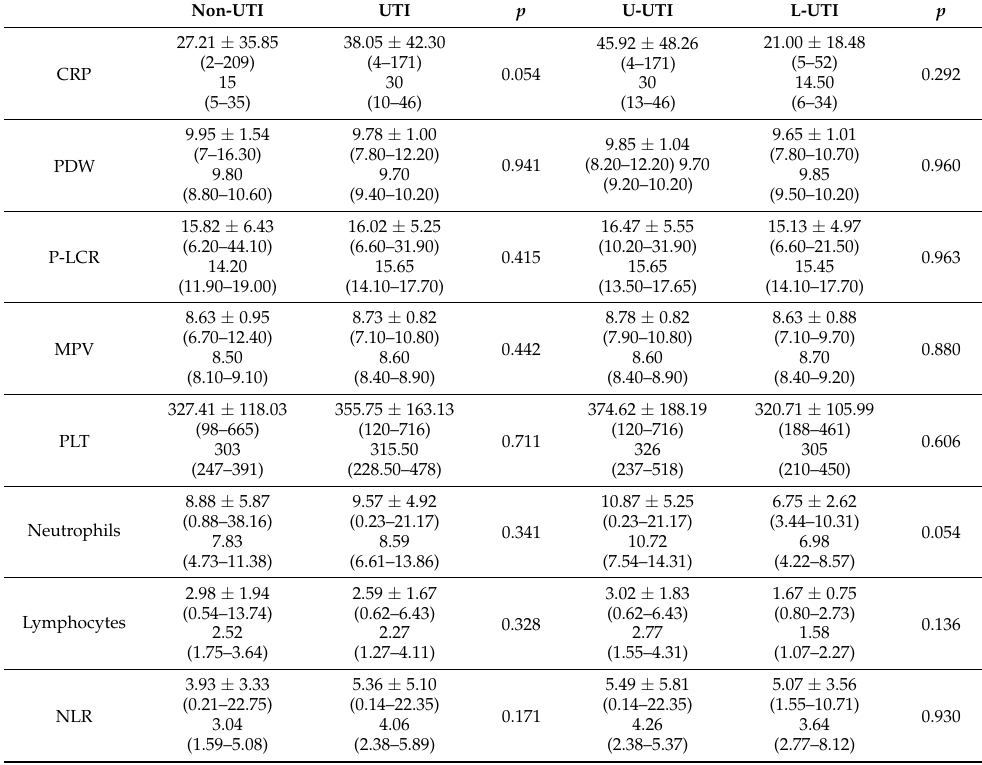
Table A2. Description of the laboratory